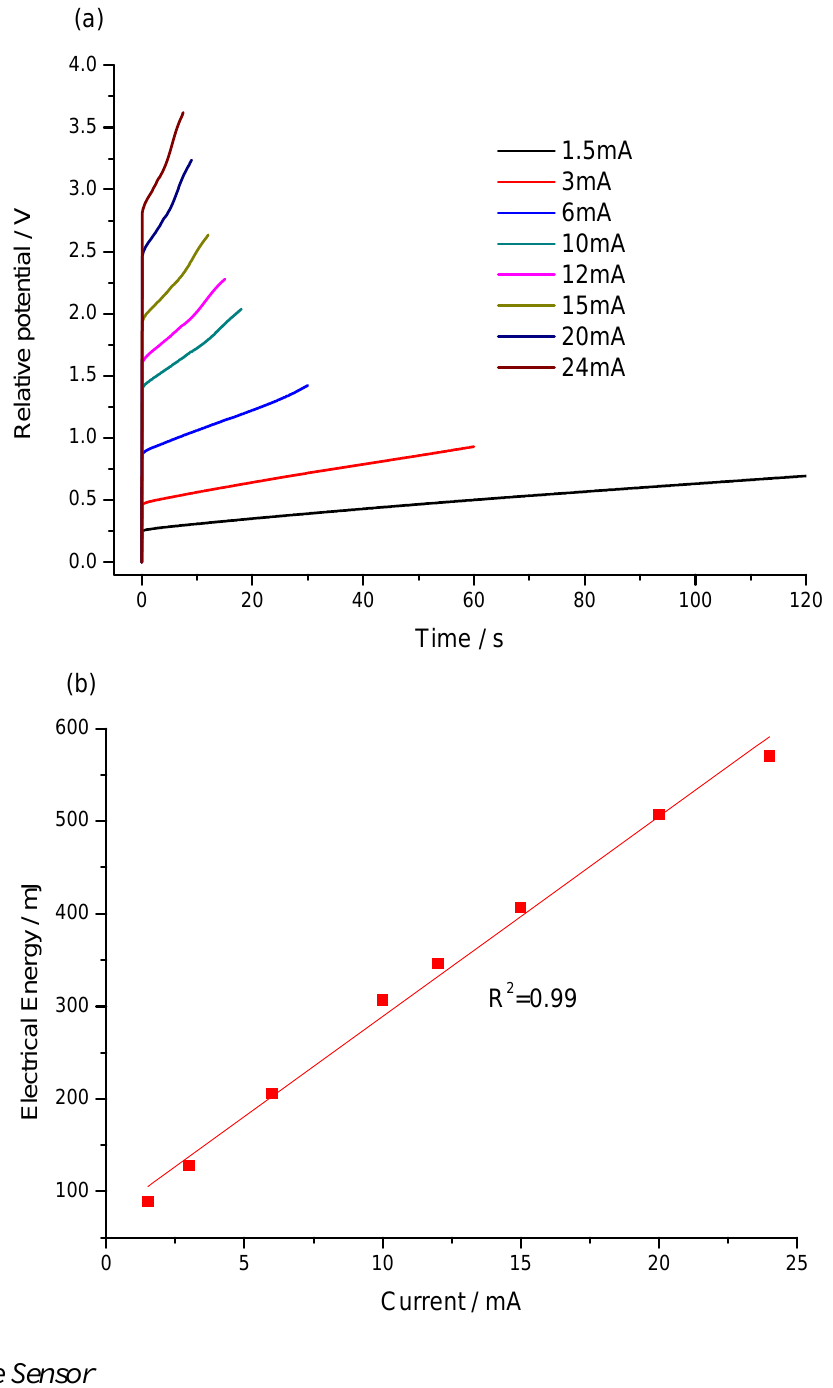
Figure 7. (a) Chronopotentiograms obtained for different anodic current pulses applied to a self supported pPy/DBSA film, flowing a constant charge of ±180 mC, in 0.1 M LiClO